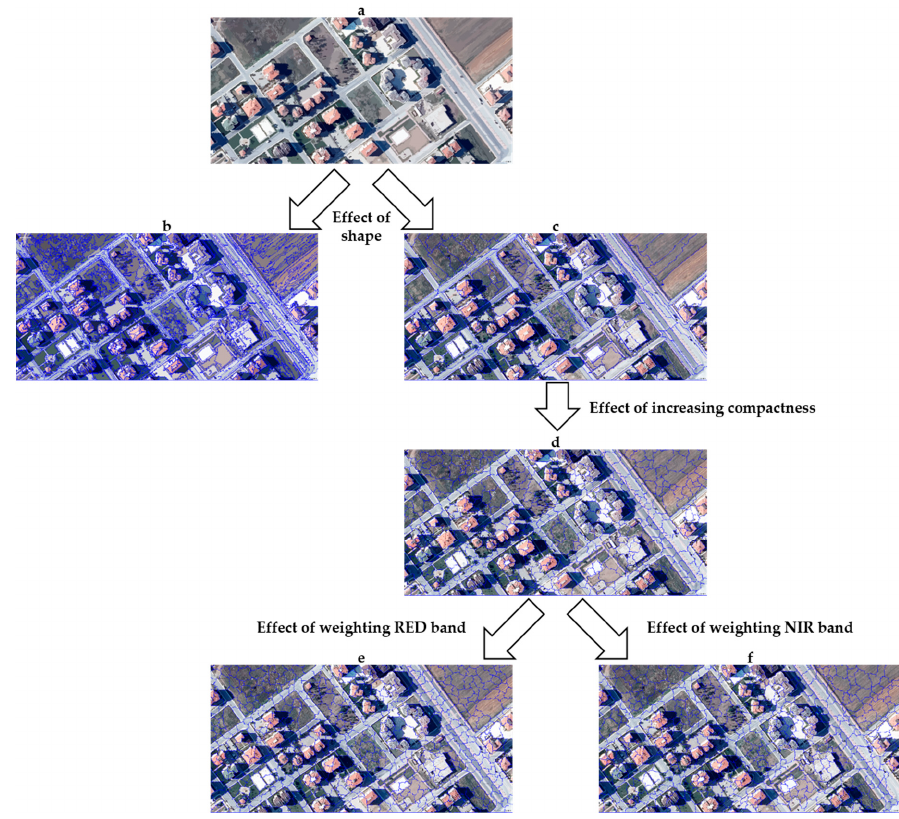
Figure 5. Comparison of segmentation attempts: ( a ) southeast of the study area, ( b ) SN 1, ( c ) SN 73, ( d ) SN 97, ( e ) SN 98, and ( f ) SN 101.